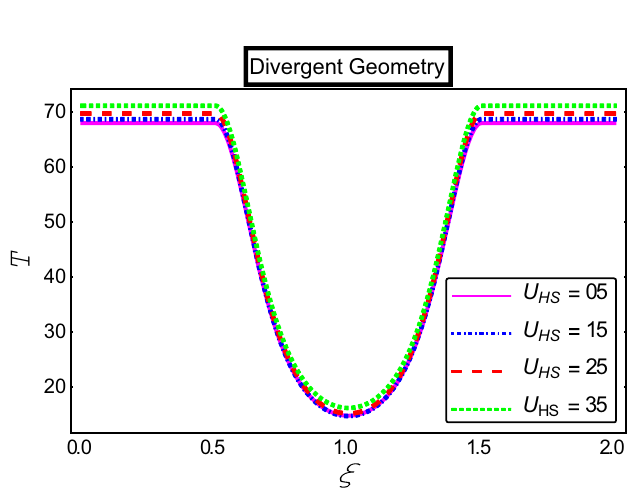
Figure 16. Impact of Helmholtz–Smoluchowski parameter on the temperature